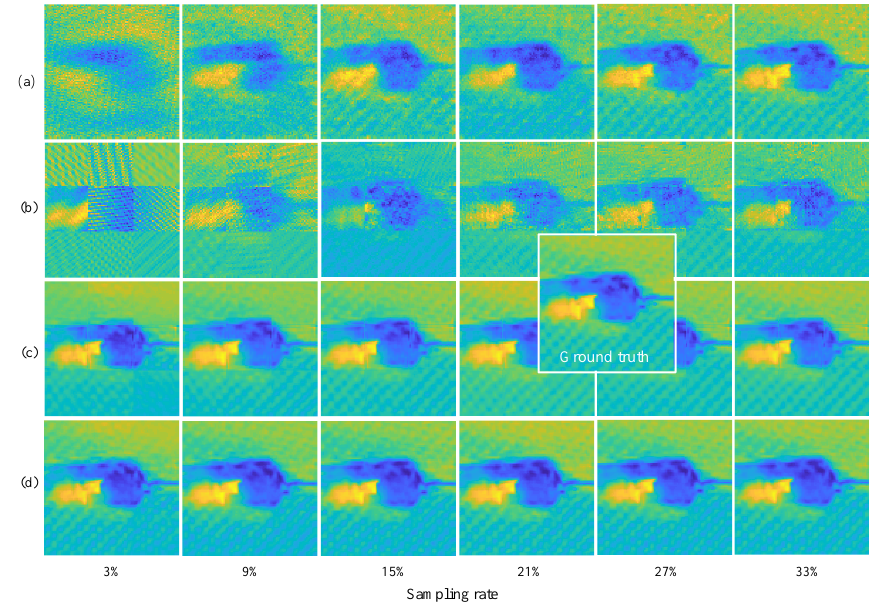
Figure 8. Imaging results on the 10 J specimen. ( a ) The OMP algorithm; ( b ) Block-by-block reconstruction with OMP; ( c ) the proposed feeder root net output; ( d ) Final output for the proposed RootsNet.